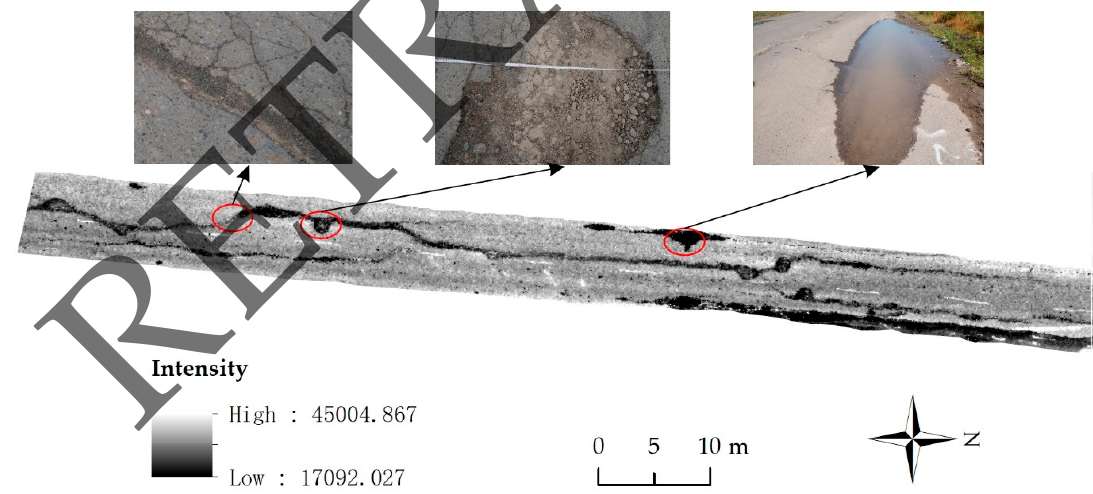
Figure 12. Reflection intensity interpolated image.